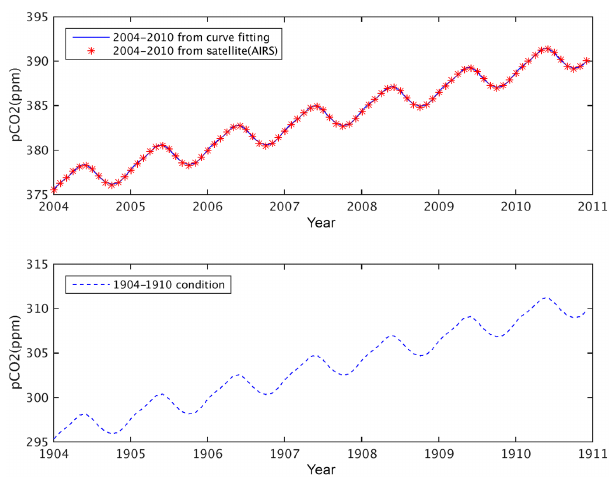
Figure 3. Satellite-observed monthly p CO 2 (AIRS) averaged over the Gulf of Mexico (red stars) and the p CO 2 air used in model air– sea CO 2 flux calculation (blue line), which is generated using the curve-fitting software